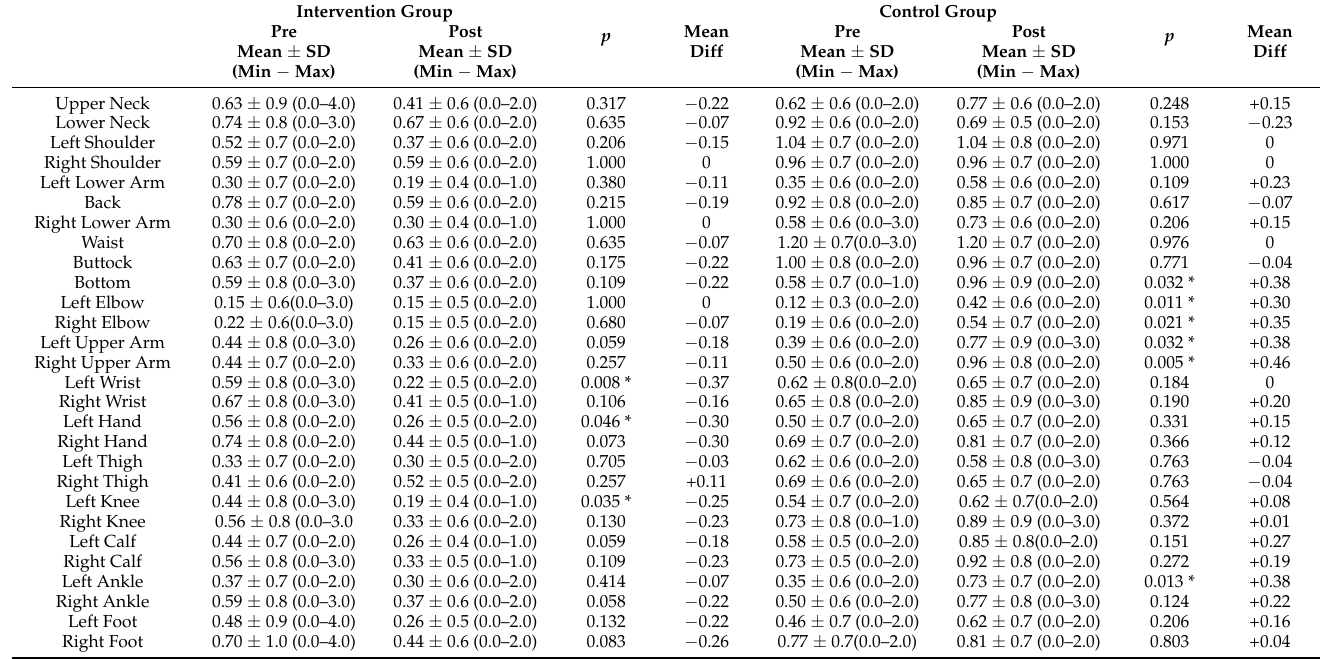
Table 4. Musculoskeletal complaints per body part. Data are expressed mean ± SD. Intervention